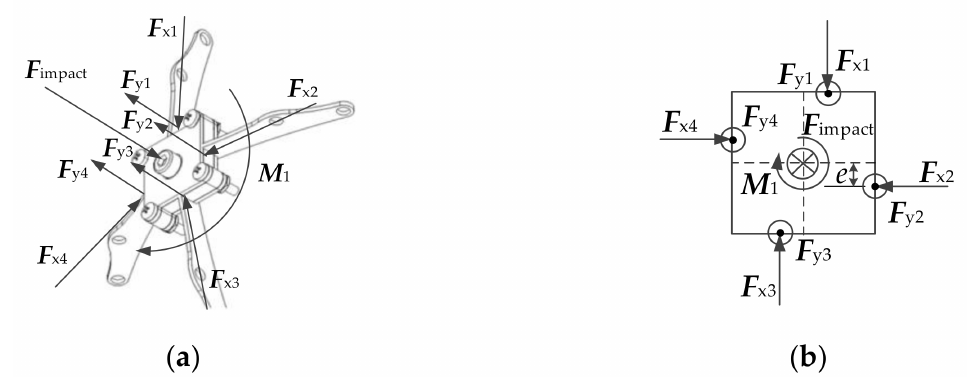
Figure 4. Force analysis of O-joint in initial stage: ( a ) Force distribution diagram; ( b ) Force analysis